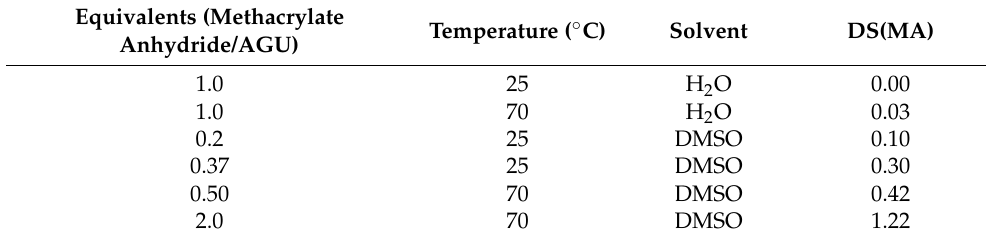
Table 1. Preparation of Dex-MA with different DS(MA).